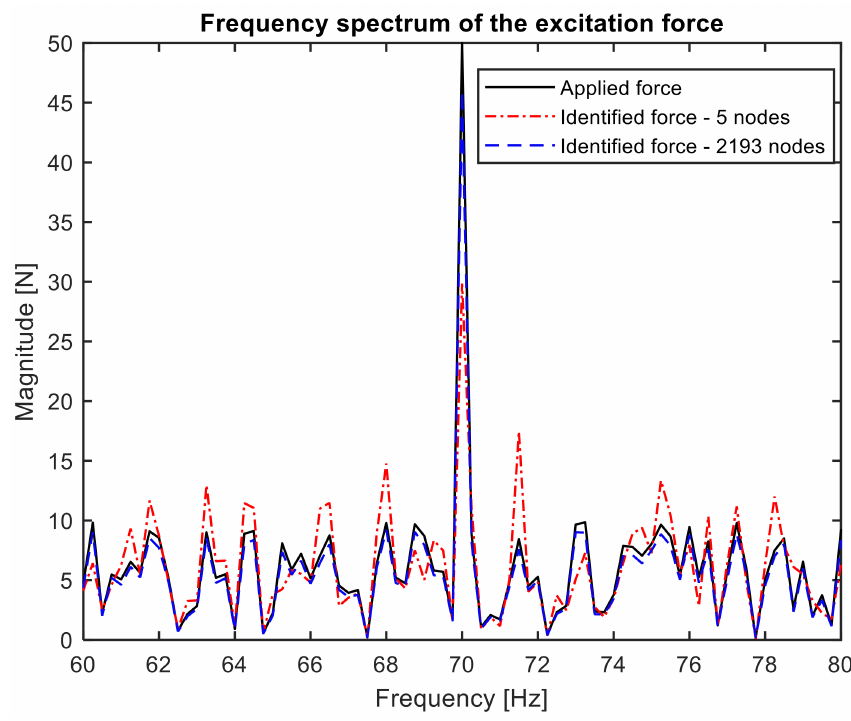
Figure 5. Comparison of the frequency spectrum of the applied and identified force. In Table 1, the obtained results are presented. Table 1. Quantitative assessment of the identification of